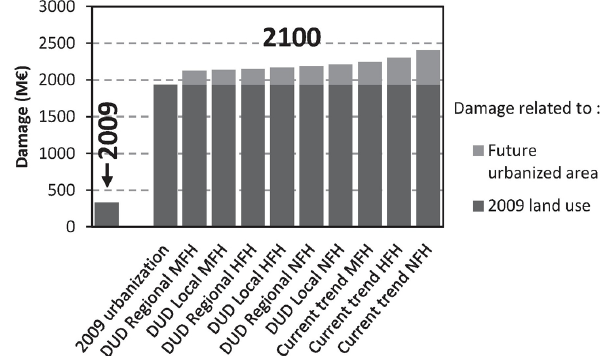
Fig. 16. Evolution of flood damage between 2009 and 2100 for a 100yr flood of the river Meuse and according to a wet climate scenario. DUD is dense urban development; MFH, no new residential areas in the medium and high flood hazard areas; HFH, no new residential areas in the high flood hazard areas; and NFH, the flood hazard map is not considered for spatial